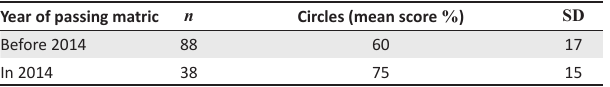
TABLE 8: Performance of students in the circles concepts in relation to pre-2014 matriculants and matriculants of 2014. Year of passing matric n Circles (mean score % ) SD Before 2014 88 60 17